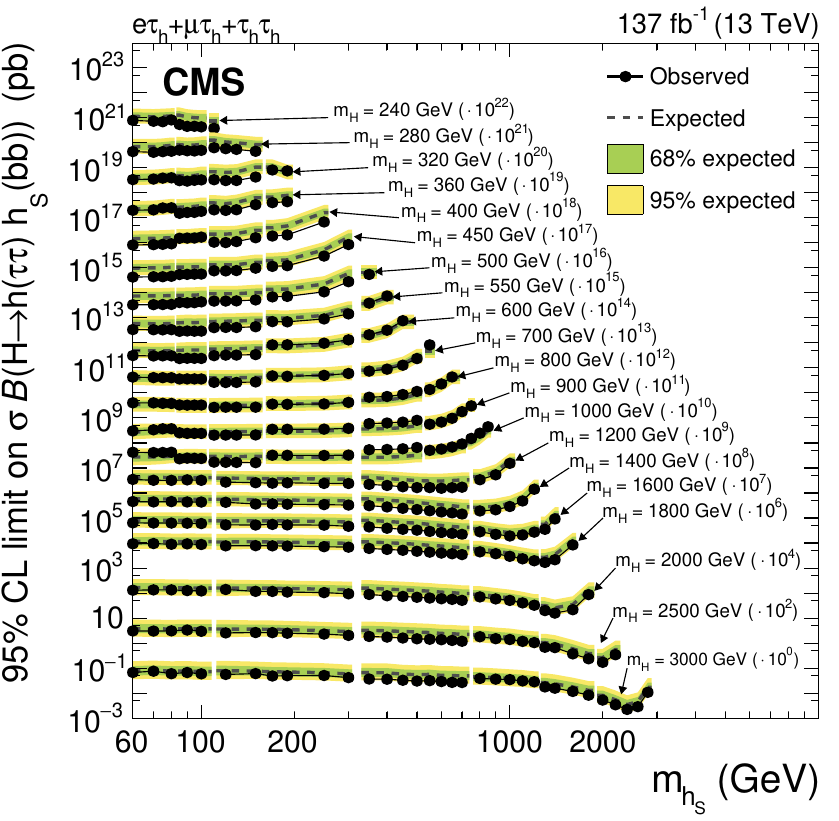
(bb)) for all tested S